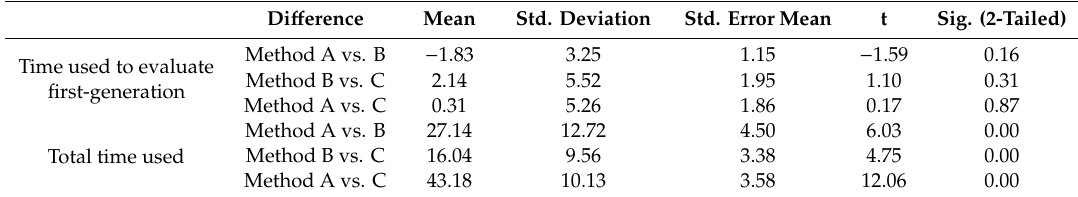
Table 4. Paired-sample T test of the time used to evaluate the first-generation and total time used with Methods A, B and C.